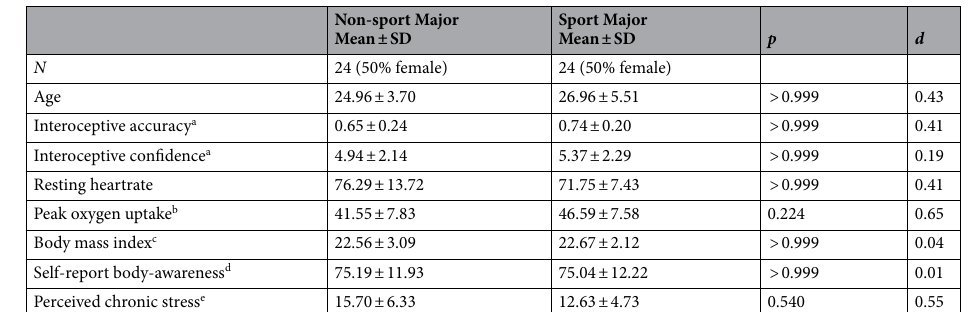
Table 4. Background characteristics of participants grouped by sporting background (students majoring in sport vs non-sport focussed courses). Data are presented as means ± standard deviations with p-values corrected for multiple comparisons. Interoceptive accuracy a (IAcc) as measured by Heartbeat Counting Task (HCT-accuracy range: 0–1, and confidence range: 0–10), Peak oxygen uptake b (